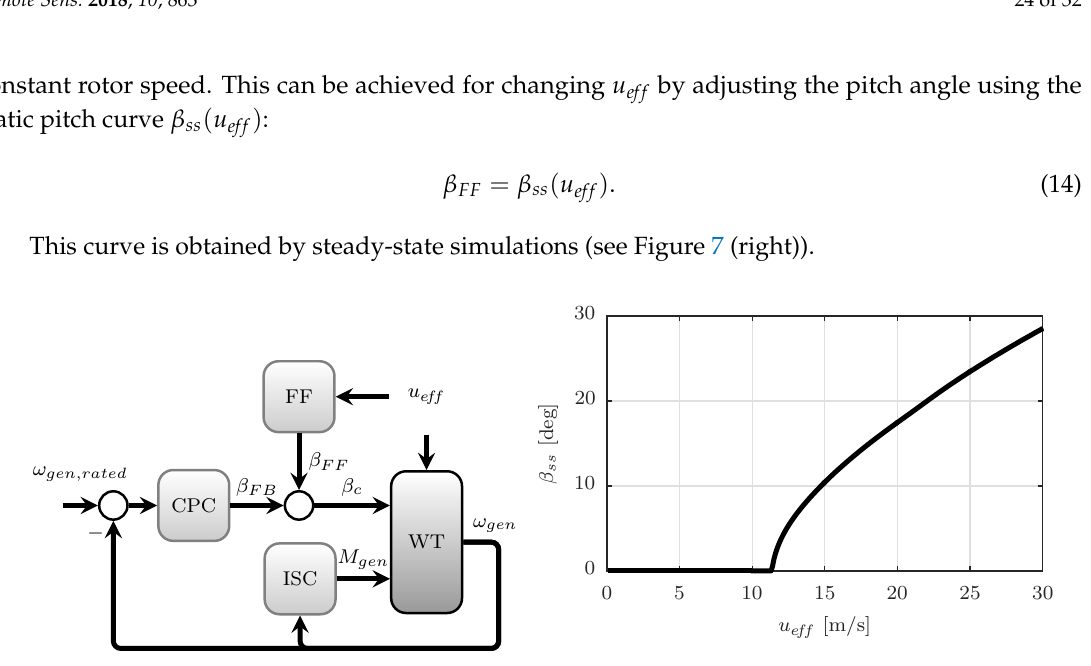
Figure 7. Feedback control loops and collective pitch feedforward control loop assuming perfect wind preview ( left ). Static pitch curve ( right